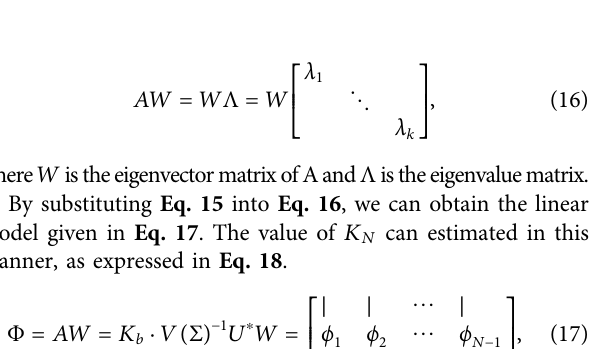
FIGURE 9 | Speed variation during no-load start-up under 413 and 418 m of water head.